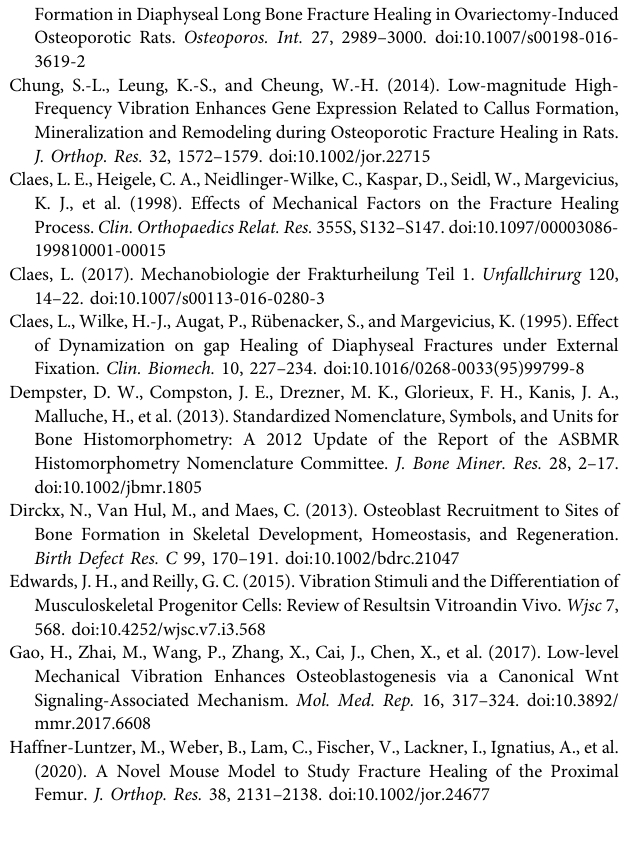
Supplementary Figure S1 | : Osteoblasts, osteocytes and hypertrophic chondrocytes are affected by the deletion of ER α , but not bone marrow cells. Immunohistochemical staining for ER α were performed on paraf fi n sections of (A,C) ER α fl / fl and (B,D) ER α fl / fl ; Runx2Cre mice . Representative images of the fracture callus, growth plate and bone marrow are shown. Scale bar (cid:1) 100 μ m in overview images of the fracture callus and 50 μ m in images 1 – 9; g (cid:1) gap. Supplementary Figure S2 | : In fl uence of OVX treatment on trabecular bone parameters. μ CT analysis of the left femora was performed to determine the relative bone volume (BV/TV) in the trabecular bone compartment of ER α fl / fl (A) and ER α fl / fl ; Runx2Cre (B) mice. The trabecular number (Tb.N) was also determined in ER α fl / fl (C) and ER α fl / fl ; Runx2Cre (D) mice. Data are shown as box-and-whisker plots (with median and interquartile range) from max. to min., showing all data points. *indicates signi fi cant effects with p ≤ 0.05; n (cid:1) 4 – 5. Supplementary Figure S3 | : In fl uence of the respective genotype on fracture healing outcome on day 21. Biomechanical testing data (bending stiffness), bony bridging score and BV/TV of the fracture calli from control groups were directly compared between ER α fl / fl and ER α fl / fl ; Runx2Cre mice. Data are shown as box-and-whisker plots (with median and interquartile range) from max. to min., showing all data points. *indicates signi fi cant effects with p ≤ 0.05. Supplementary Figure S4 | : Nondetailed STRING protein-association network (action) derived from the MC3T3-E1 microarray data in high